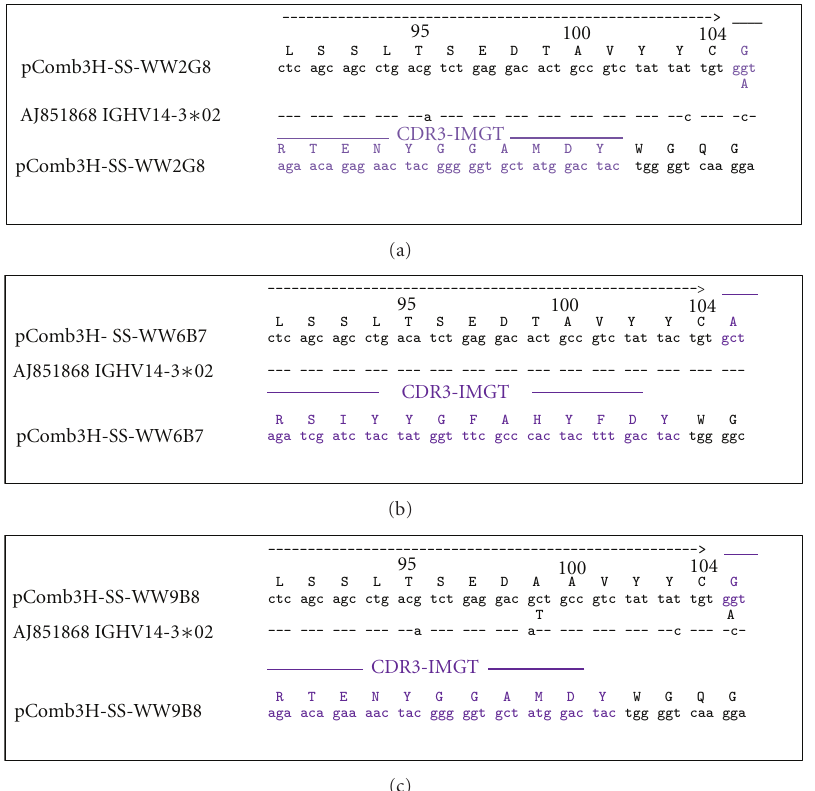
Figure 2: CDR3 sequences of anti-MICA monoclones. Nucleotide and deduced amino acid sequences of V segment of (a) WW2G8, (b) WW6B7, and (c) WW9B8 compared with the reference sequence to identify CDR3. This region was randomly mutated by PCR mutagenesis creating a library of mutated CDR3 on WW2G8, WW6B7, and WW9B8 frameworks, and the high a ffi nity phages were reselected by bio- panning. Dashes indicate identical